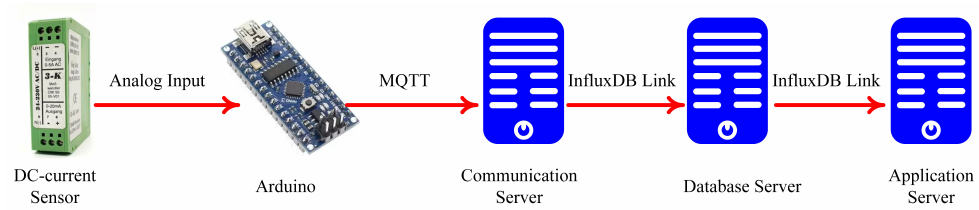
Figure 8. Data acquisition process for the DC-Current sensors deploying smart sensors. The micro- controller uses MQTT to send data to the